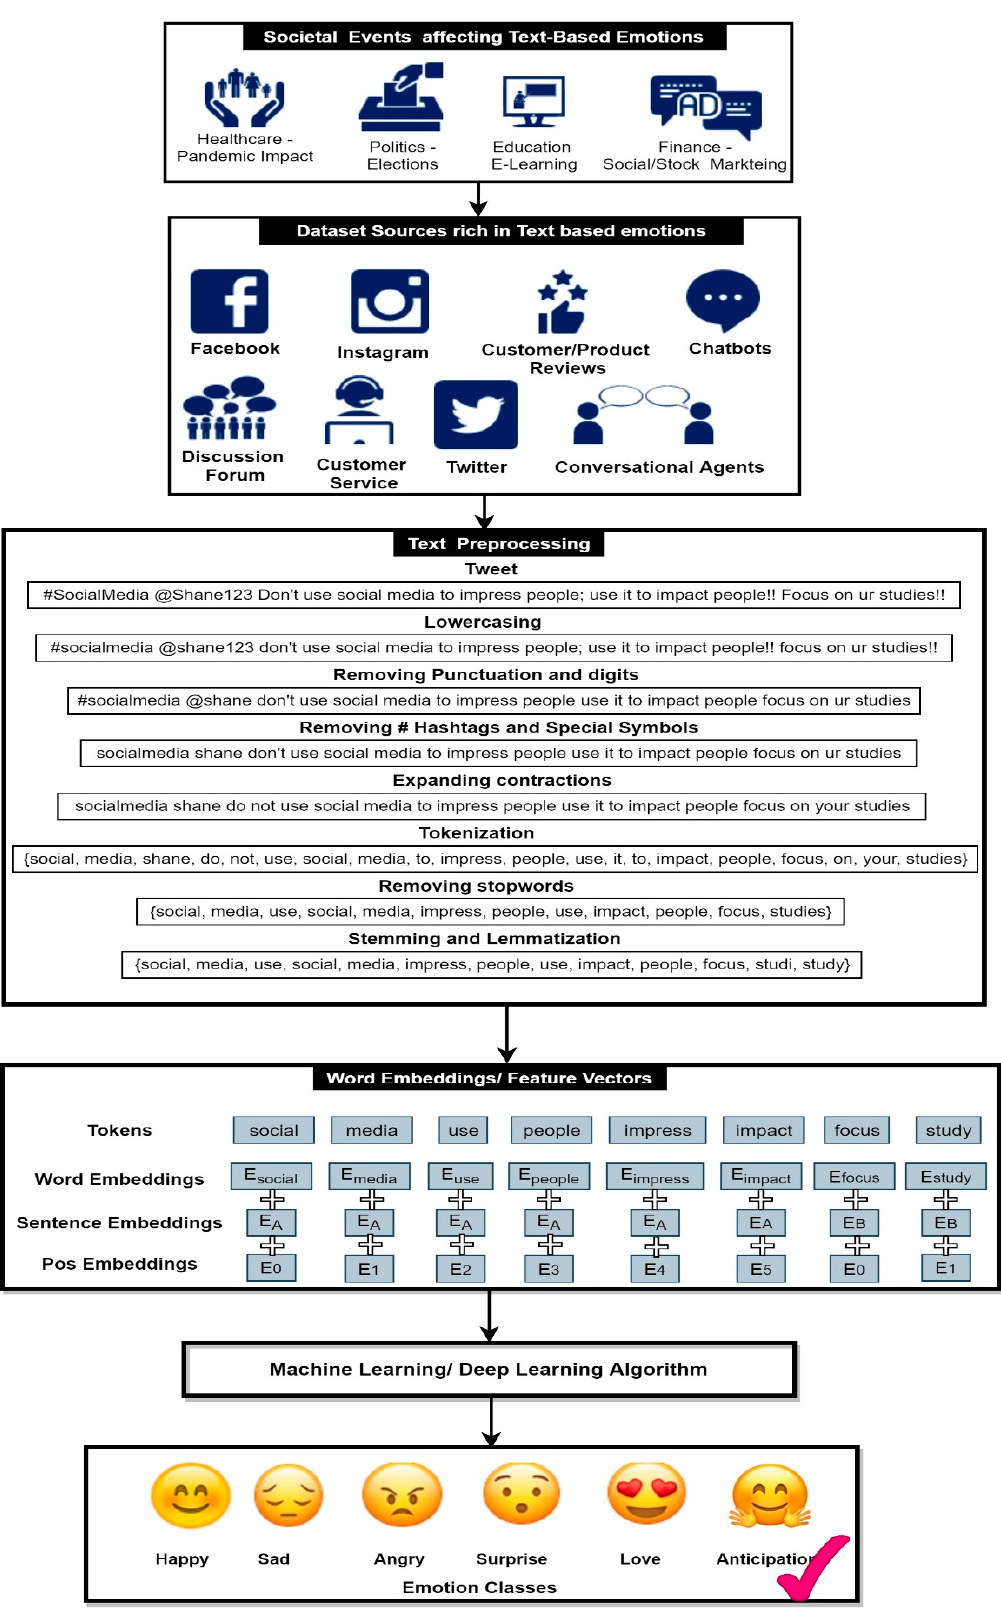
Figure 1. Text preprocessing along with process flow of text-based emotion detection using artificial intelligence.